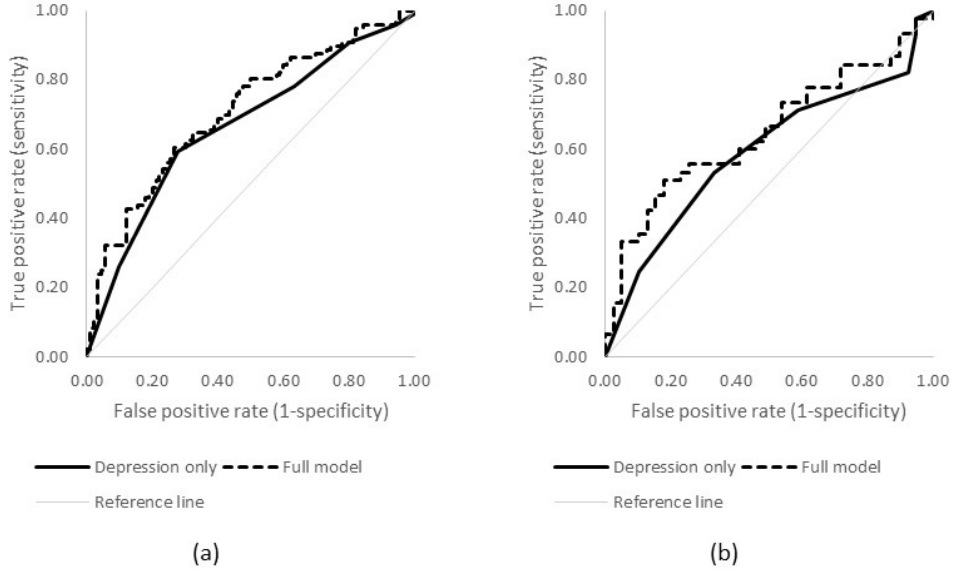
Figure 1. ROC curves predicting lifetime suicidal ideation for ( a ) females and ( b ) males.